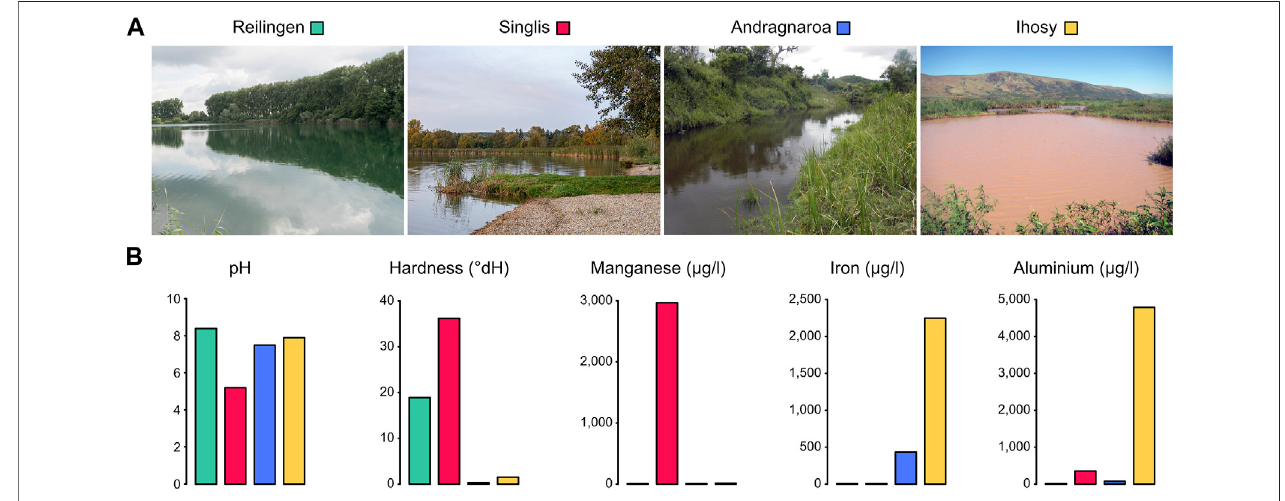
FIGURE 1 | Marbled cray fi sh population habitats. (A) Habitat pictures of the four populations analyzed in this study (B) Selected water parameters of the four habitats analyzed.